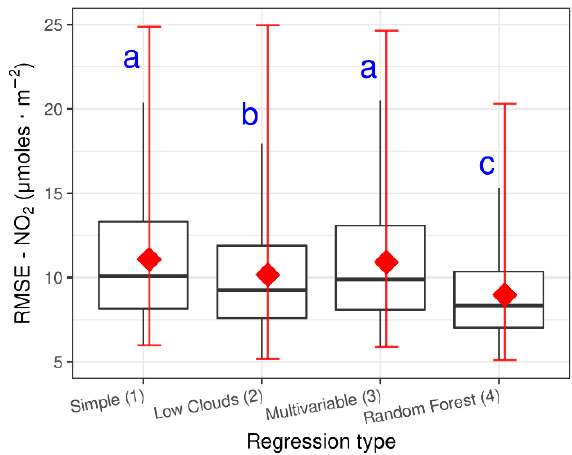
Figure 8. RMSE distributions for the four regression types (see Table 2) with letters accounting for significant difference at 99% confidence level from the Mann- Whitney U test. Boxplot is interquartiles and median. Red dot and line are mean and standard